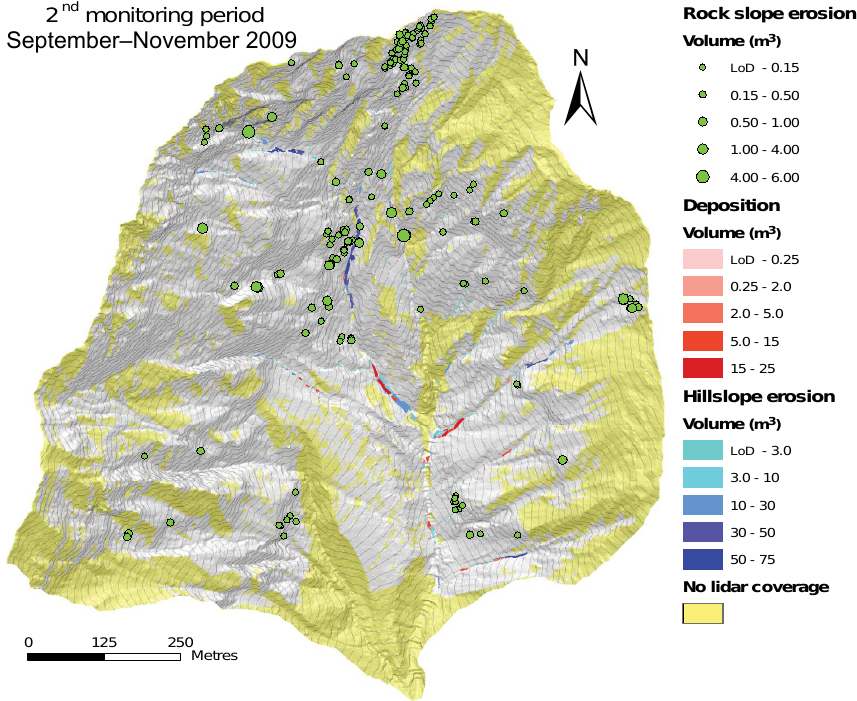
Figure 8. Geomorphic activity revealed by comparing the topographic differences of the two successive TLS surveys operated in August and November 2009. The sediment budgets for each subcatchment are detailed in Fig.